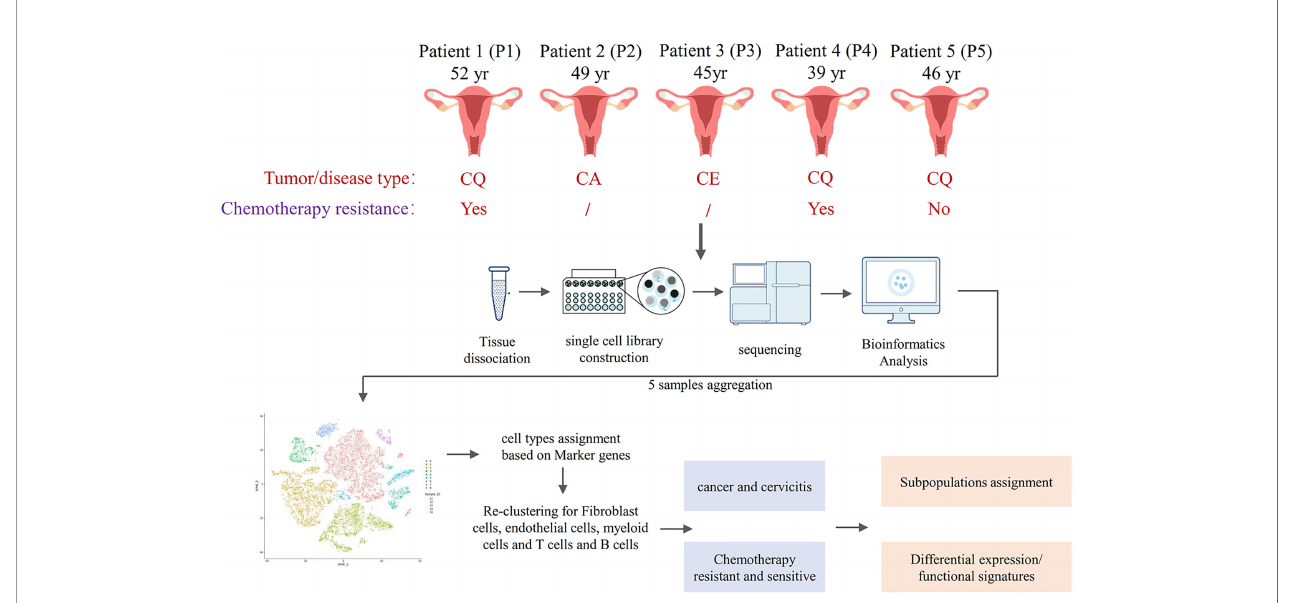
FIGURE 2 | Overview of single-cell RNA sequencing (scRNA-seq) using cervical cancer and cervicitis biopsy